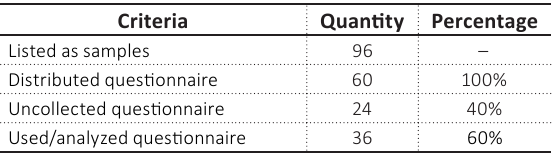
Table 1. Research